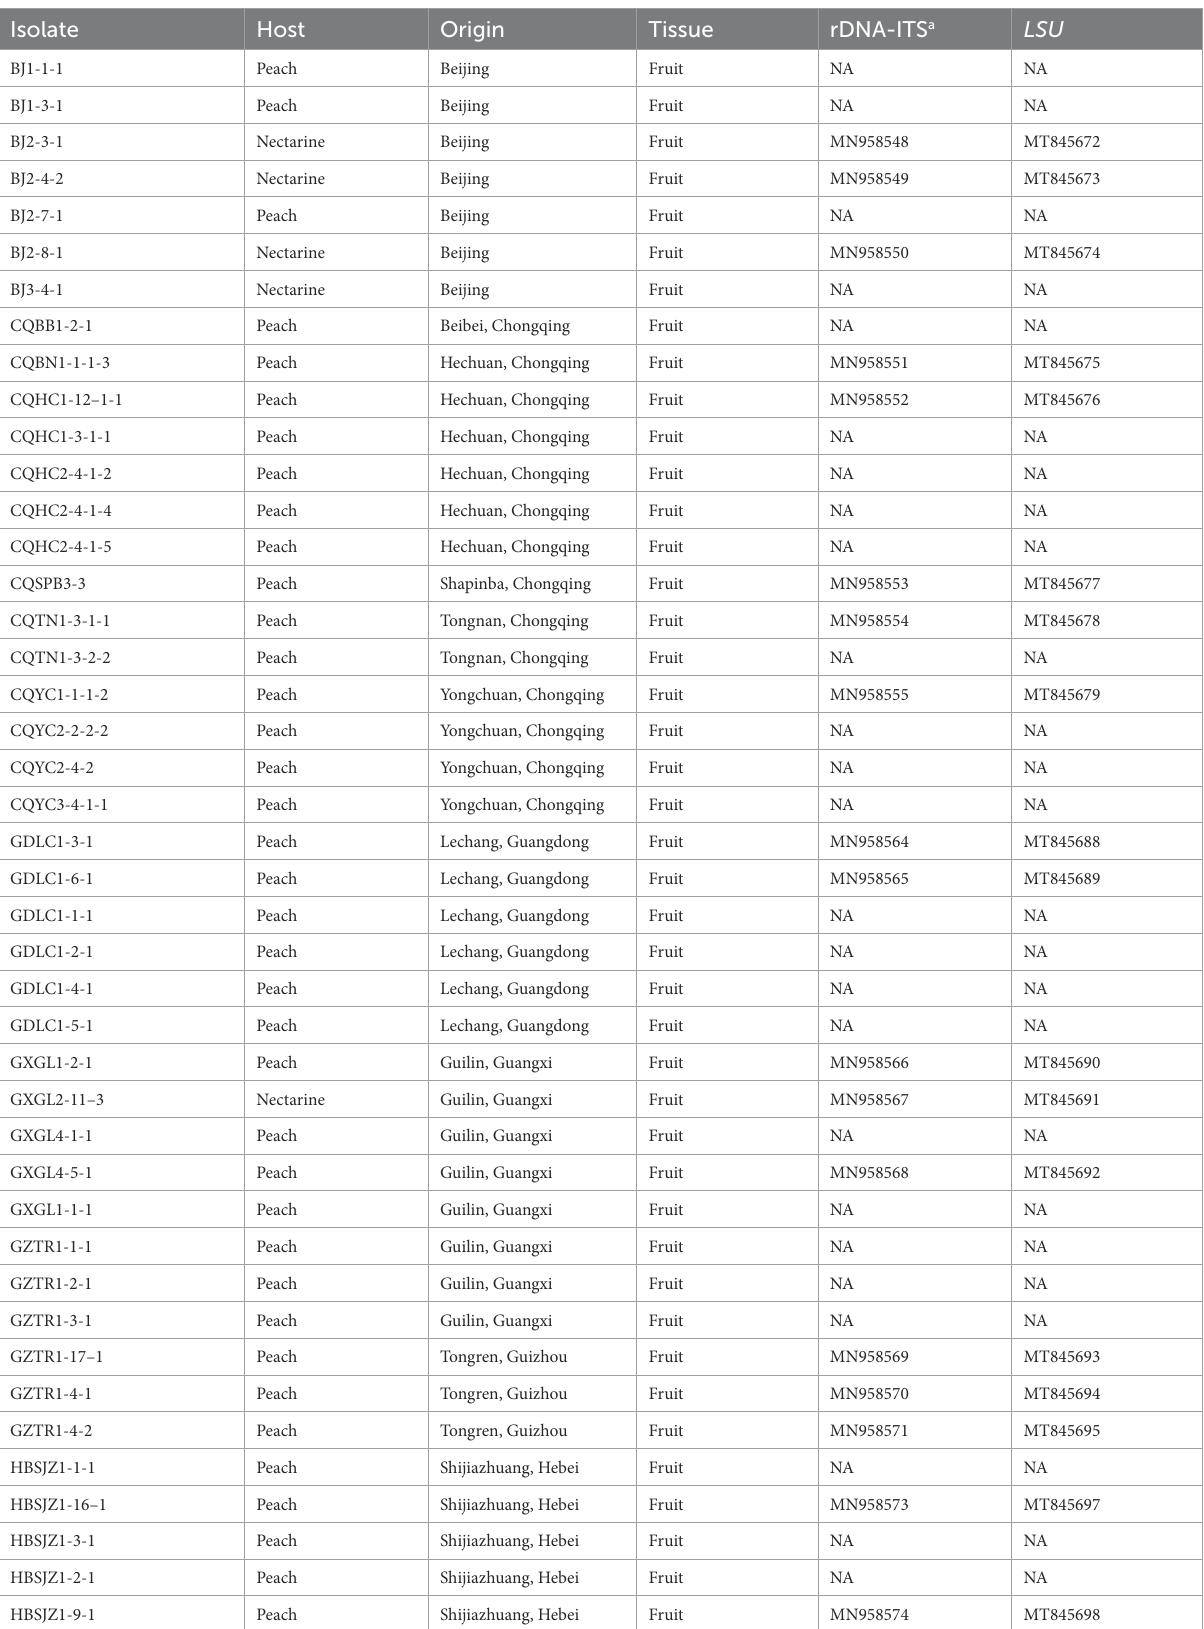
TABLE 1 Sampling geographic regions, host, cultivar, and tissue of isolates of Venturia carpophila collected to assess population genetic diversity. Isolate Host